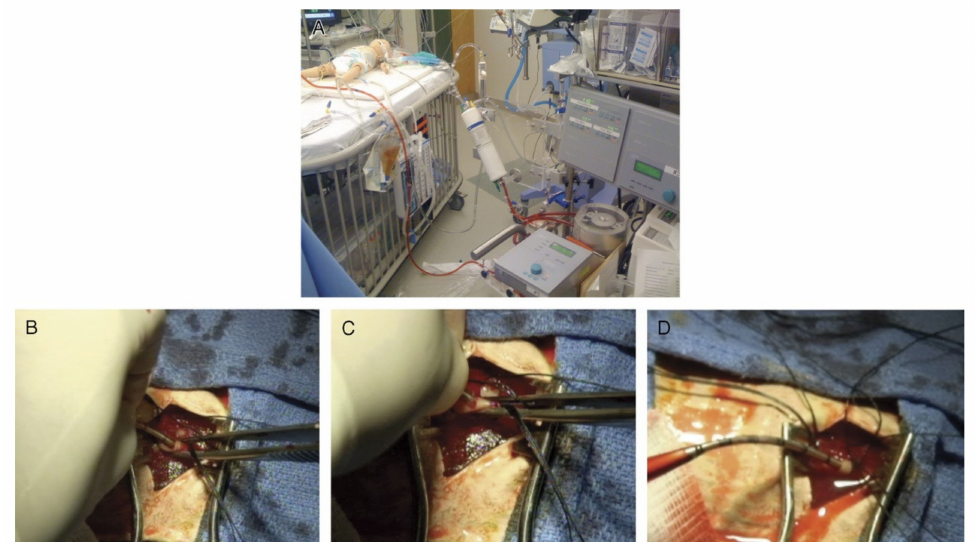
Figure 6. Neonatal ECMO cannulation simulator featuring oozing ( A ) Overall system ( B , C ) cannula- tion with standard flow with oozing ( D ) bleeding from operative site